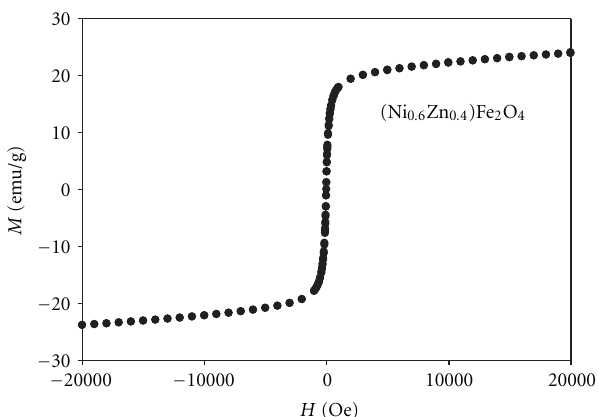
Figure 6: Magnetization of (Ni 0 . 6 Zn 0 . 4 )Fe 2 O 4 nanoparticles at 300K, reaching saturation near 2,000 Oe.